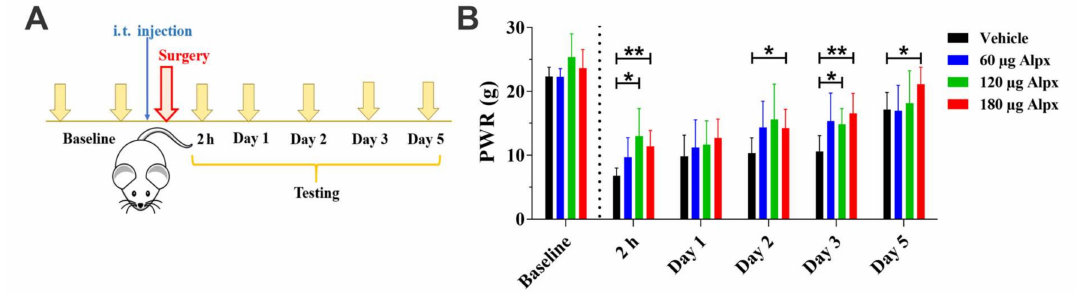
Figure 2. The preemptive administration of Alphaxalone alleviates postincisional